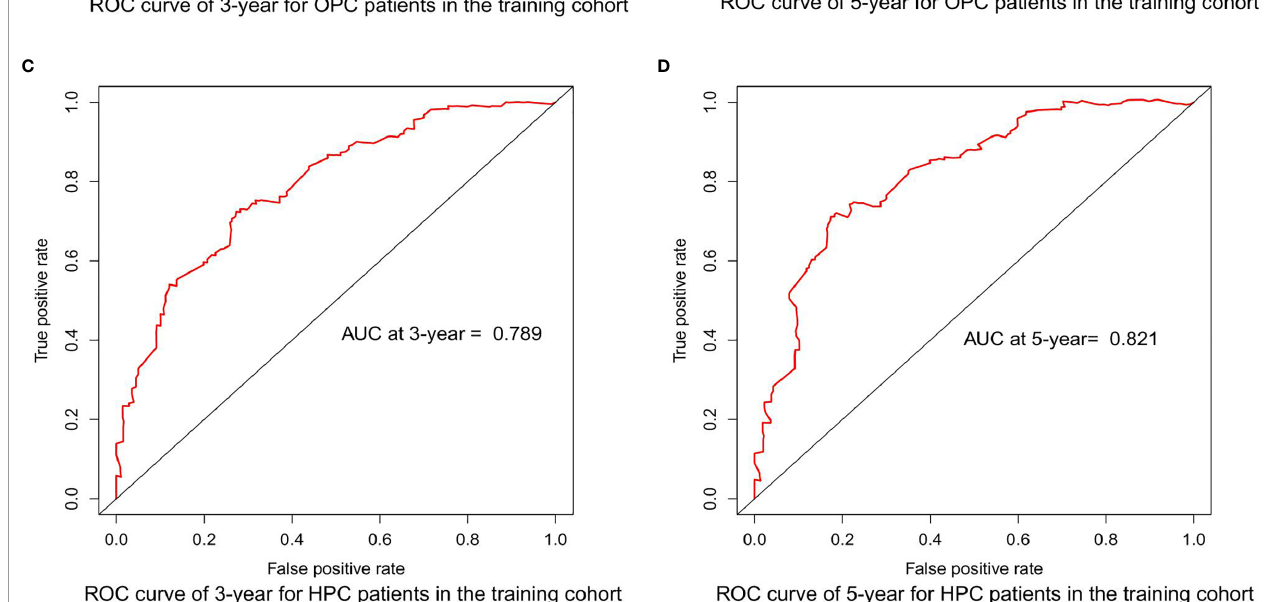
FIGURE 4 | ROC curves depicting the predictive performance of the survival nomograms in the training cohorts. (A, B) ROC curves for the 3- and 5-year OS of OPC patients in the training cohort; (C, D) ROC curves for the 3- and 5-year OS of HPC patients in the training cohort. ROC, receiver-operating characteristic; OS, overall survival; FP, false positive; TP, true positive; OPC, oropharyngeal carcinoma; HPC, hypopharyngeal